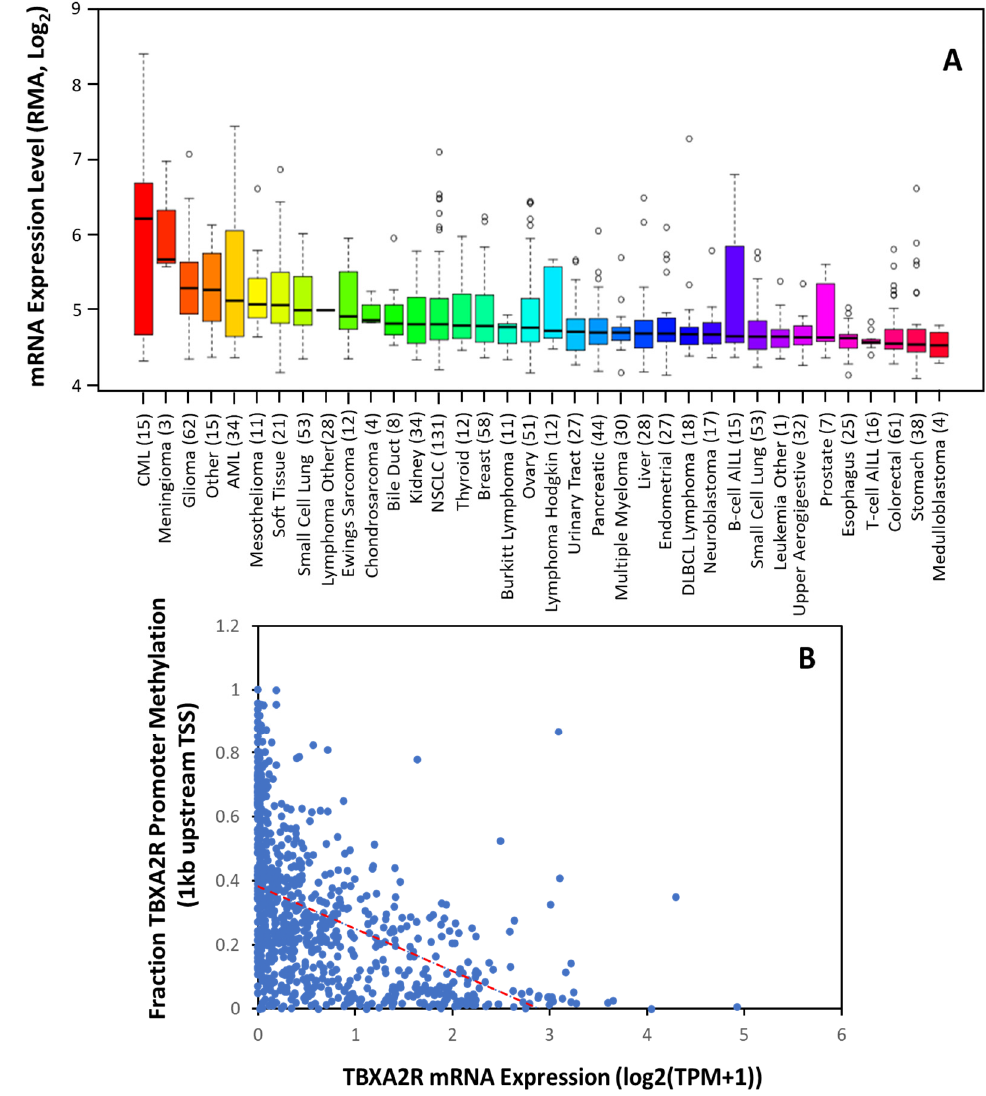
Figure 2. TBXA2R Expression is Increased in The Majority of Tumors. ( A ) Expression of TBXA2R mRNA in 36 different cancer cell types. Data are mean ± SD showing 95% CI. Numbers above descriptors on the X -axis denote the number of individual cell lines from which the data were derived. ( B ) TCGA data from 59,132 patients’ samples showing the correlation between TBXA2R mRNA expression and methylation of the promoter (within 1 kb of transcriptional start site (TSS)). Red dotted line denotes linear correlation (R 2 = 0.442).